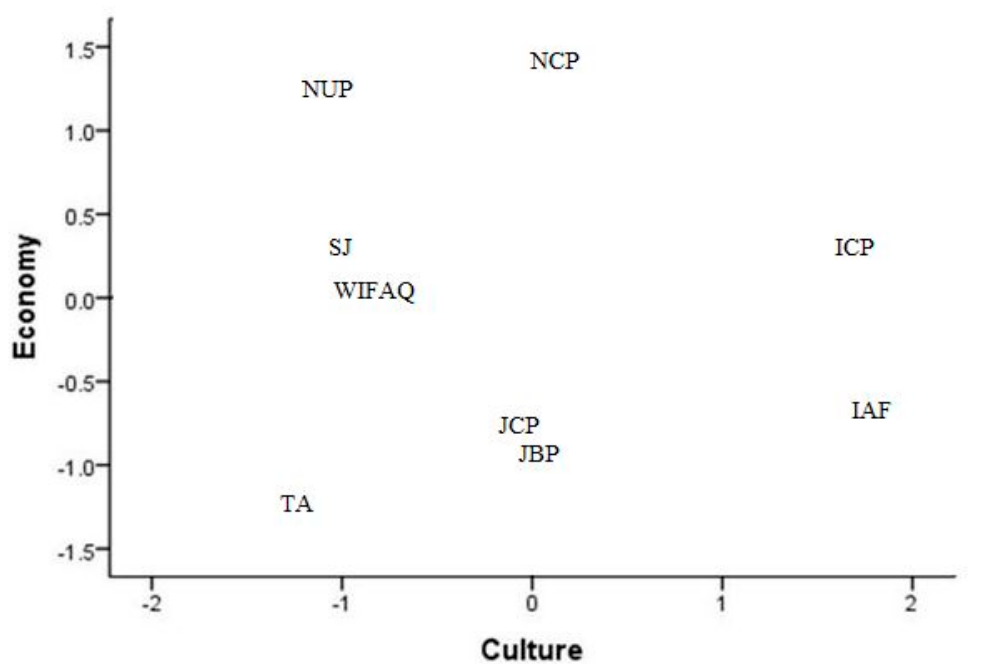
Figure 6. Ideological map of Jordanian parties, 2013. TA: National Current Party; SJ: Stronger Jordan; ICP: Islamic Center Party.